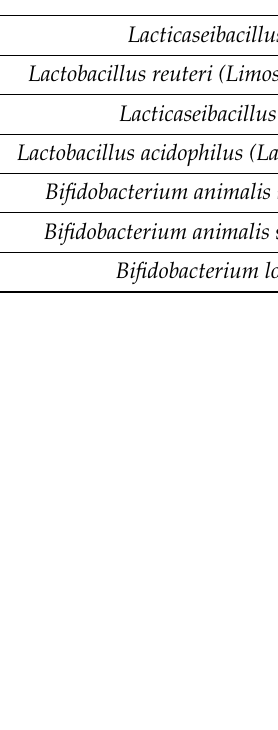
Figure 4. OMV count performed by flow cytometry. The graphs represent the concentration of total and eDNA-containing pOMVs and bOMVs, obtained from treated (T) and untreated (NT) samples with sub-MIC concentrations of carvacrol ( A ), thymol ( B ), and amoxicillin ( C , D ). * p < 0.05 vs. the non-treated sample. Table 4. CA classes and their accession numbers identified in the genome of the considered probiotics. Probiotic